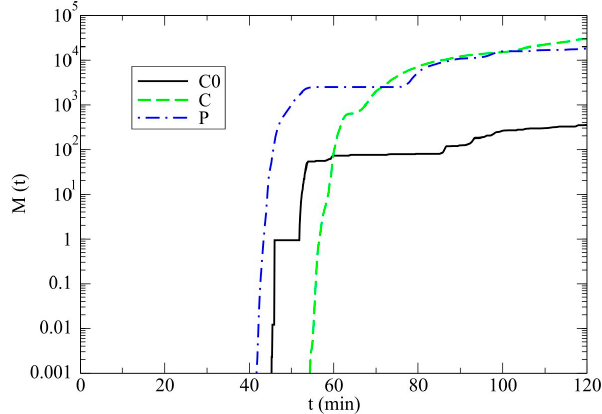
Figure 9. As in Figure 5, but for the cumulative sum of the initial production of hail (tonnes) by autoconversion of hailstone embryos (graupel and frozen raindrops). Atmosphere 2018 , 9 , 13